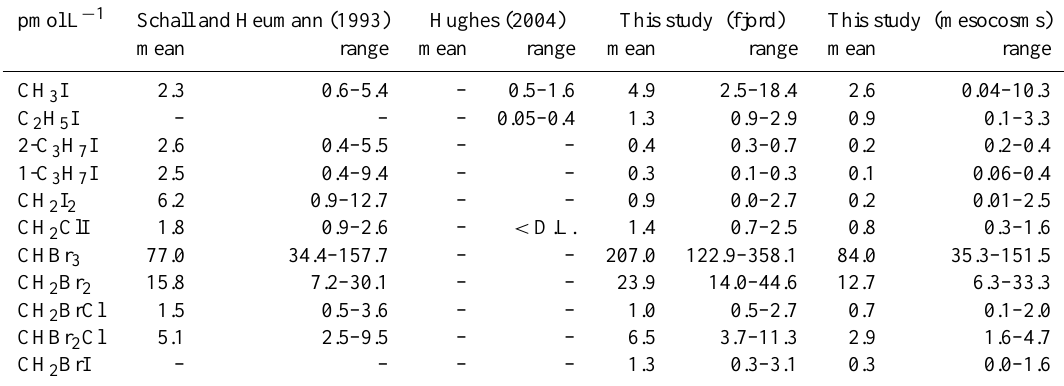
Table 2. Seawater concentrations of halocarbons in Kongsfjorden reported by Schall and Heumann (1993), Hughes (2004) and measured during this study. pmolL − 1 Schall and Heumann (1993) Hughes (2004) This study (fjord) This study (mesocosms) mean range mean range mean range mean